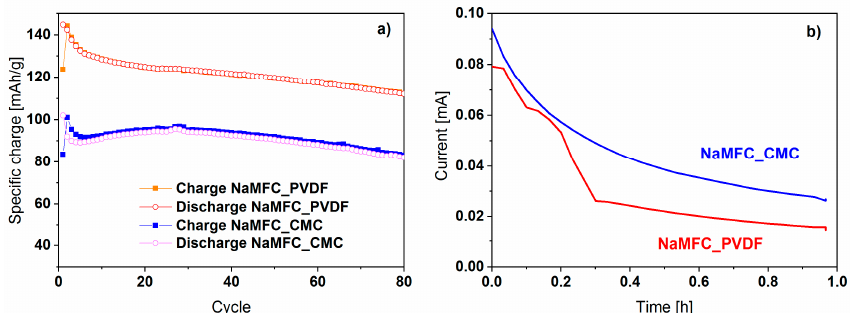
Figure 4. ( a ) Electrochemical performance of NaMFC electrodes obtained at C/10 using CCCV (Constant Current Constant Voltage) protocol; ( b ) Evolution of the current during the potentiostatic step at 4.5 V vs. Na + /Na at the end of the 1 st charge.